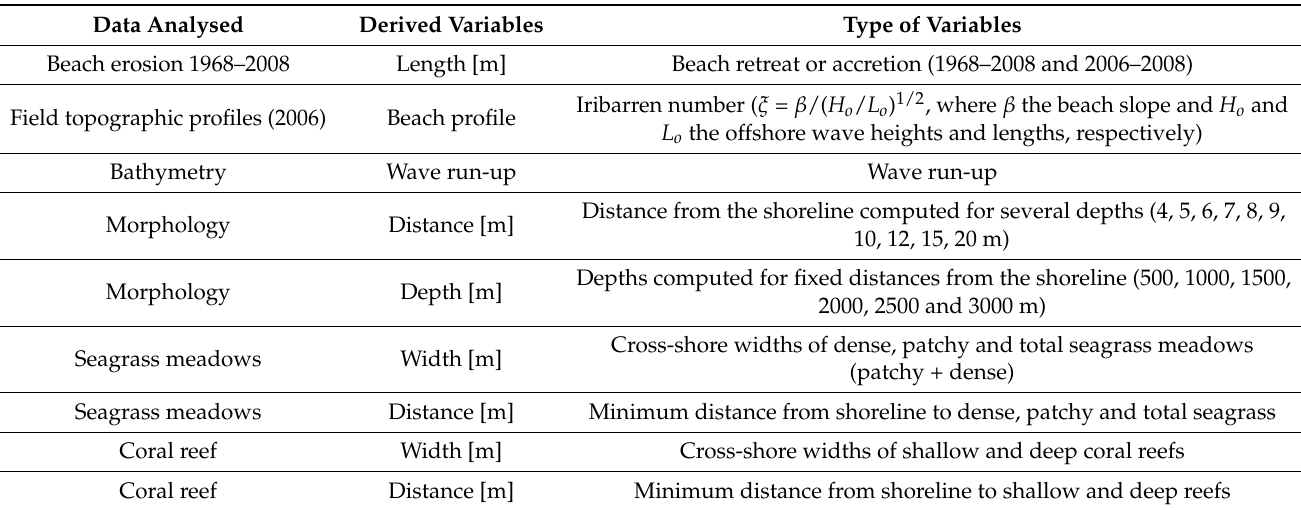
Table 2. Variables extracted for each of the 74